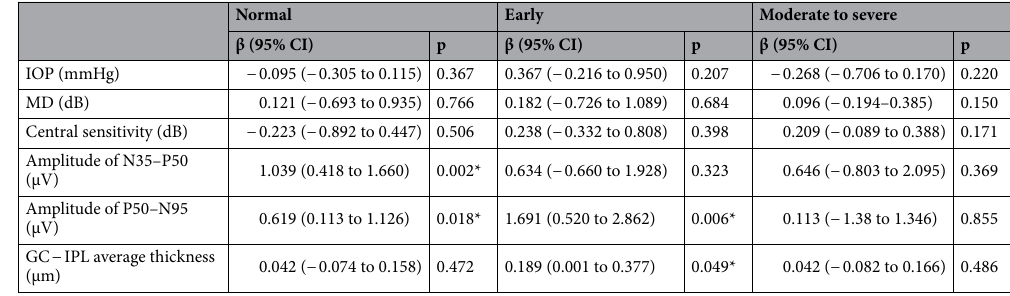
Table 3. Age-adjusted correlation analysis between macular vessel density and other parameters for glaucoma evaluation in the normal, early, and moderate to severe NTG groups. CI confidence interval IOP